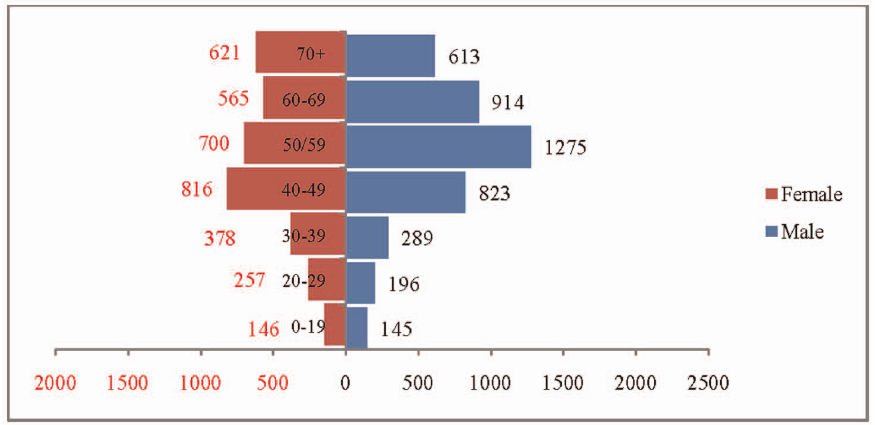
Figure 8. Estimated number of hospitalisation due to CVDs (in 000’s) by age and sex, India.